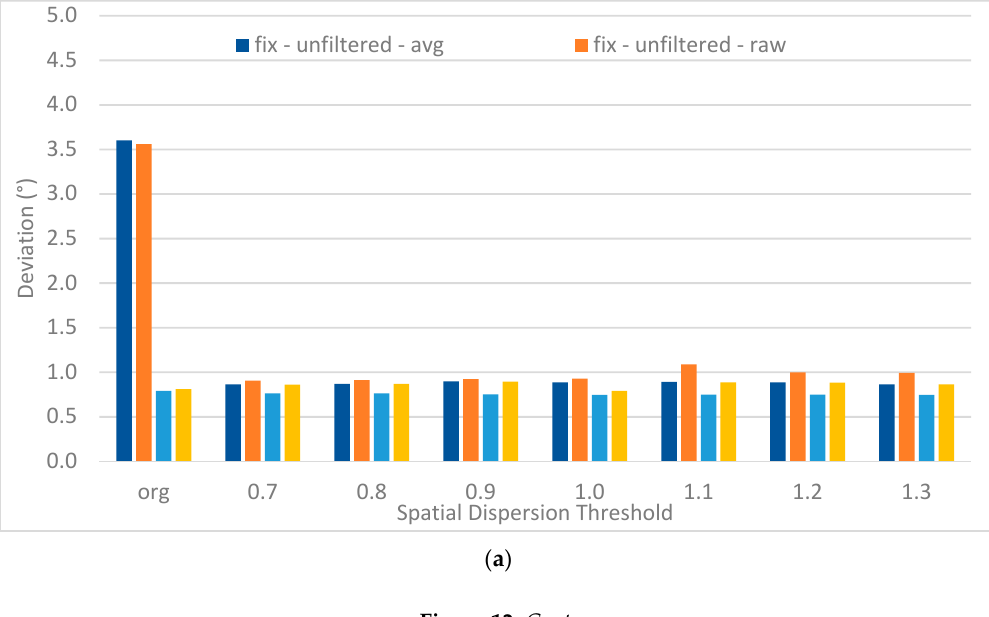
( b ) Figure 12. Deviations (visual angle) for the case of threshold 1.0° for 13 targets ( a ) and 5 targets ( b ) for all participants (in °). Table 5. Statistical (repeated measures) tests on the application of the EyeMMV’s algorithm ( df = 7 ⎯ org values + 7 thresholds; df = 6 ⎯ only thresholds). ?